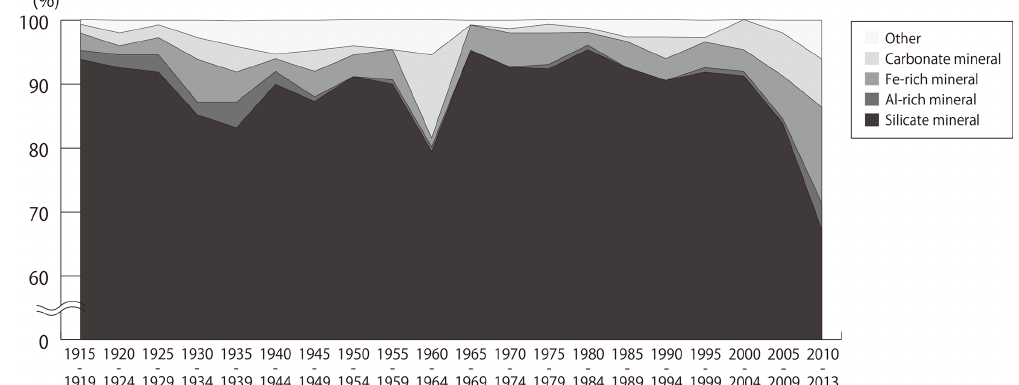
Figure 6. Variations in the insoluble mineral records in the ice core in 5-year resolution.